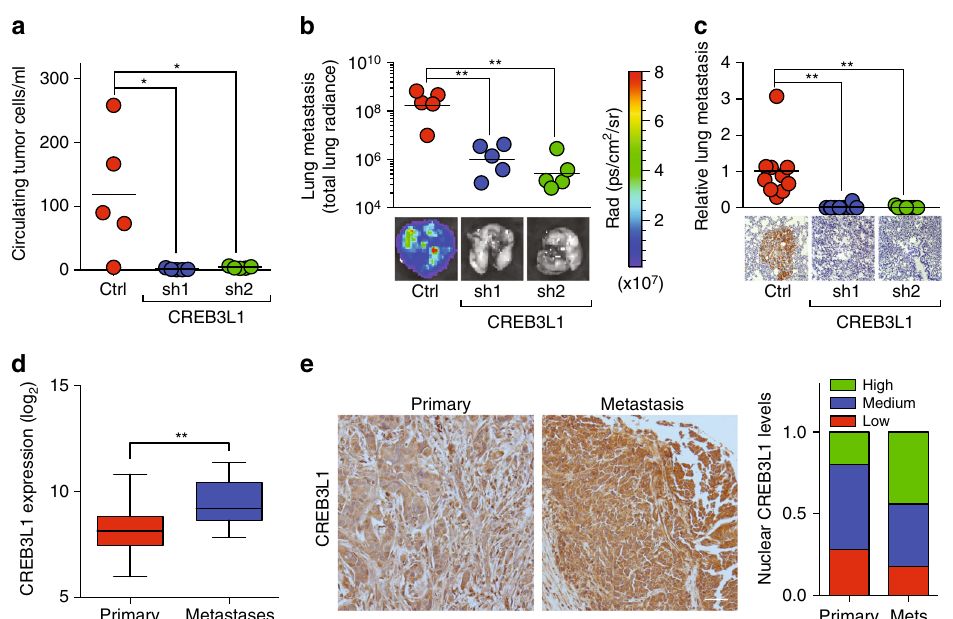
Fig. 3 CREB3L1 is required for metastasis and is upregulated in the metastases of breast cancer patients. a A quanti fi cation of circulating tumor cells (CTCs) per ml of blood from NOD/SCID mice 7 weeks after being transplanted with MDA.MB.231-Luc-LM2 cells transduced with shRNAs targeting LacZ or CREB3L1, n = 5. b Lung metastases of the animals in a were quanti fi ed (top) by radiance of the whole lung in each animal, n = 5. Total radiance was also imaged (bottom). c Lung metastases of the animals in a was gauged by immunohistochemistry staining for GFP-positive cancer cells in lung sections. GFP area per fi eld was quanti fi ed (top) and imaged (bottom), n = 10,10,9 for Ctrl, sh1, and sh2, respectively (scale bar: 40 µ m). d Expression of CREB3L1 in 529 primary breast cancer tissues and 45 breast cancer metastases (GSE20565, GSE20685, GSE7904, and GSE3744) shown as a box-and-whiskers plot. e Immunohistochemical staining for CREB3L1 in a tissue microarray containing primary breast cancer tissues (left, n = 50) and breast cancer metastases in lymph nodes (middle, n = 50). Nuclear CREB3L1 levels were quanti fi ed (right). Scale bar: 40 µ m. Data are represented as mean ± SEM or the mean alone. * indicates p < 0.05; ** indicates p < 0.01 (Student ’ s t